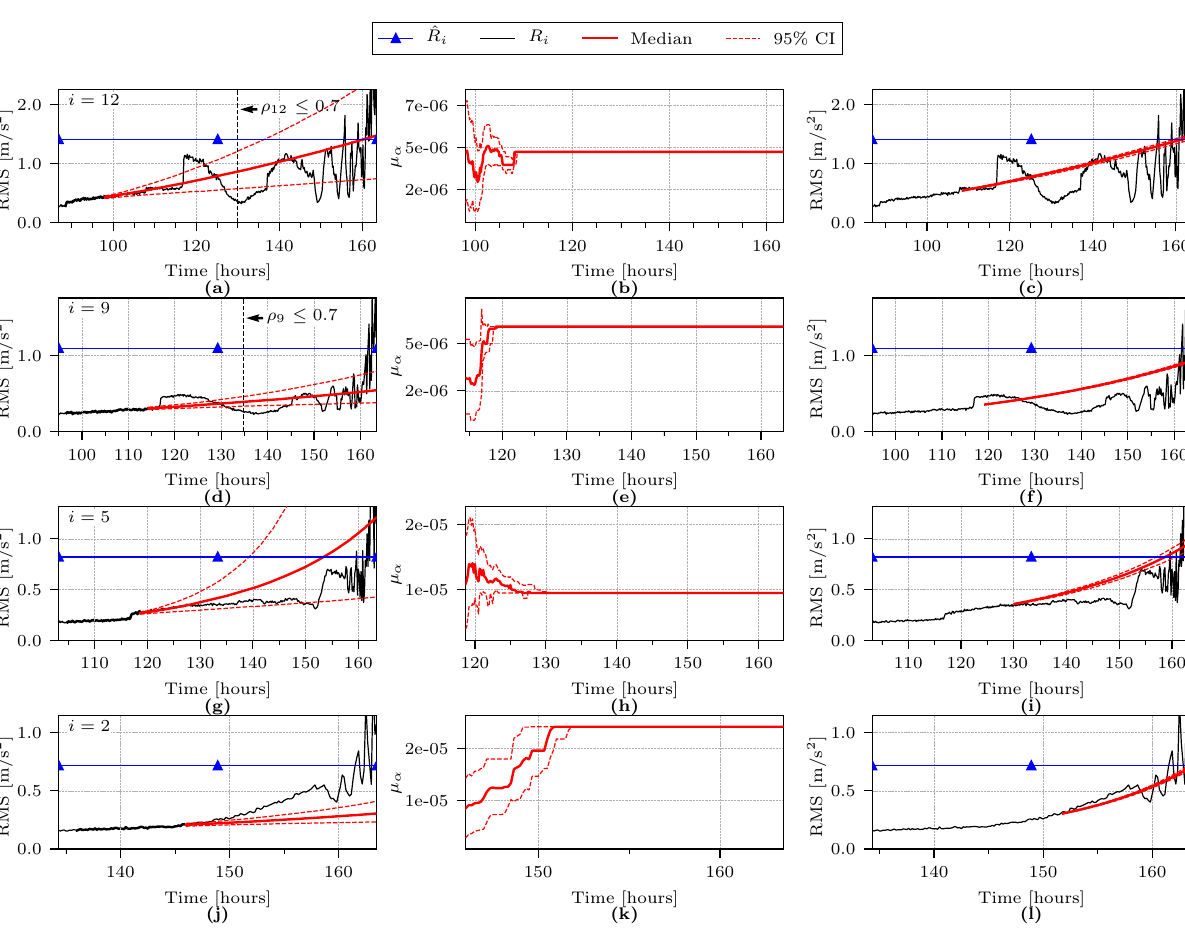
over time for the α